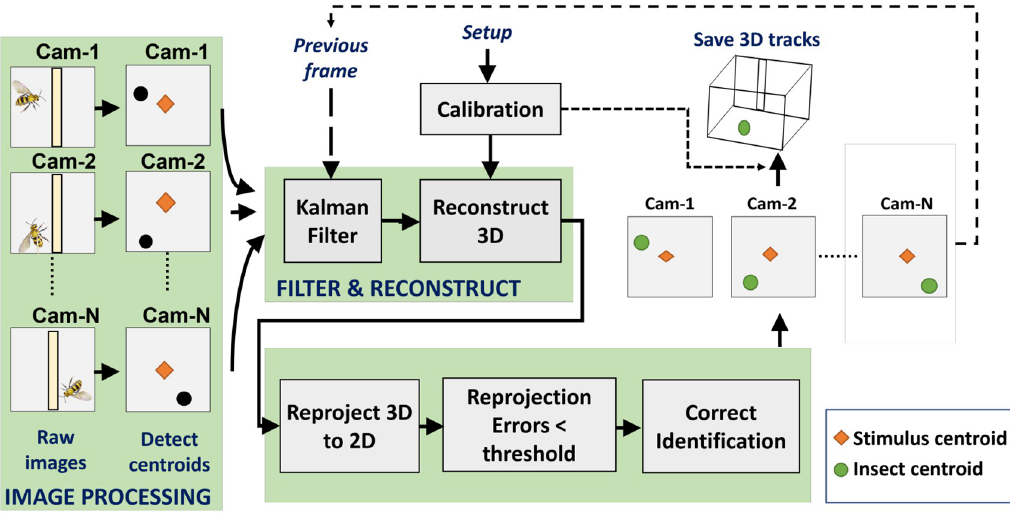
Fig 2. Flowchart of tracking